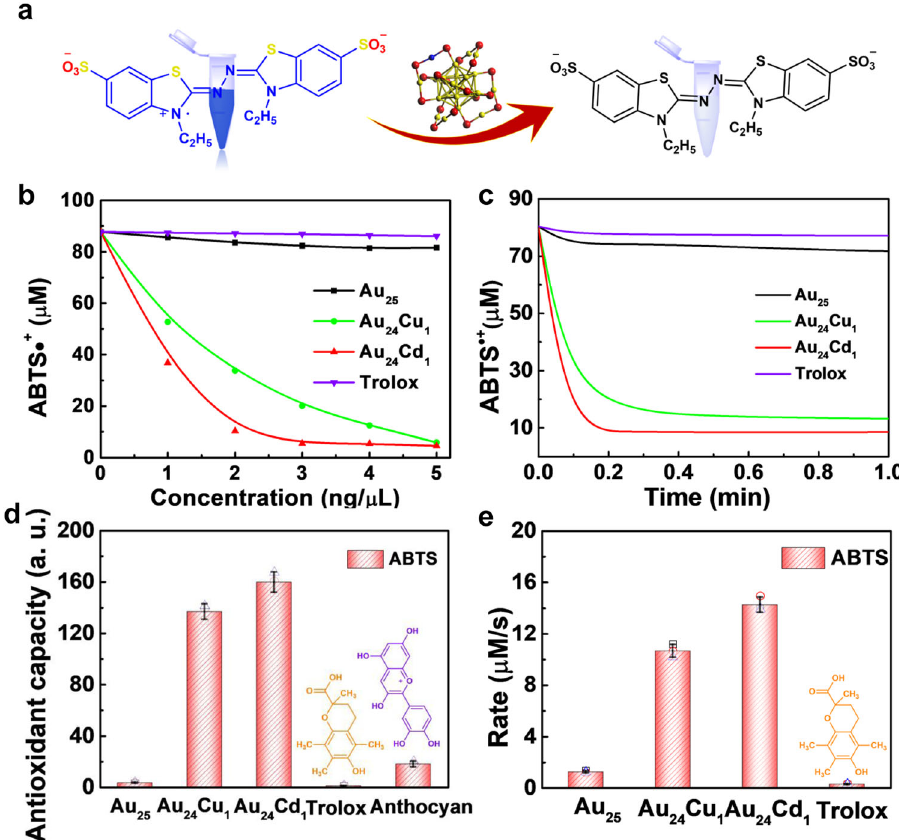
Fig. 2 The total antioxidant capacity of clusterzymes. a Schematic illustration of the reaction mechanism of the ABTS assay. b Concentration-dependent (0 – 5 ng/ µ L) and c time-dependent investigation of ABTS (cid:129) + in the presence of Au 25 , Au 24 Cu 1 , and Au 24 Cd 1 . d Comparison of the antioxidant capacities and e reaction rates of Au 25 , Au 24 Cu 1 , and Au 24 Cd 1 and natural antioxidants show that the antioxidant performance is greatly improved after one atom substitution with Cu or Cd ( n = 3 independent experiments, data are presented as mean ± SD). Compared with natural antioxidants, Au 24 Cu 1 and Au 24 Cd 1 show 137 and 160 times higher activity than trolox, and 7.5 and 9 times higher activity than anthocyanin,